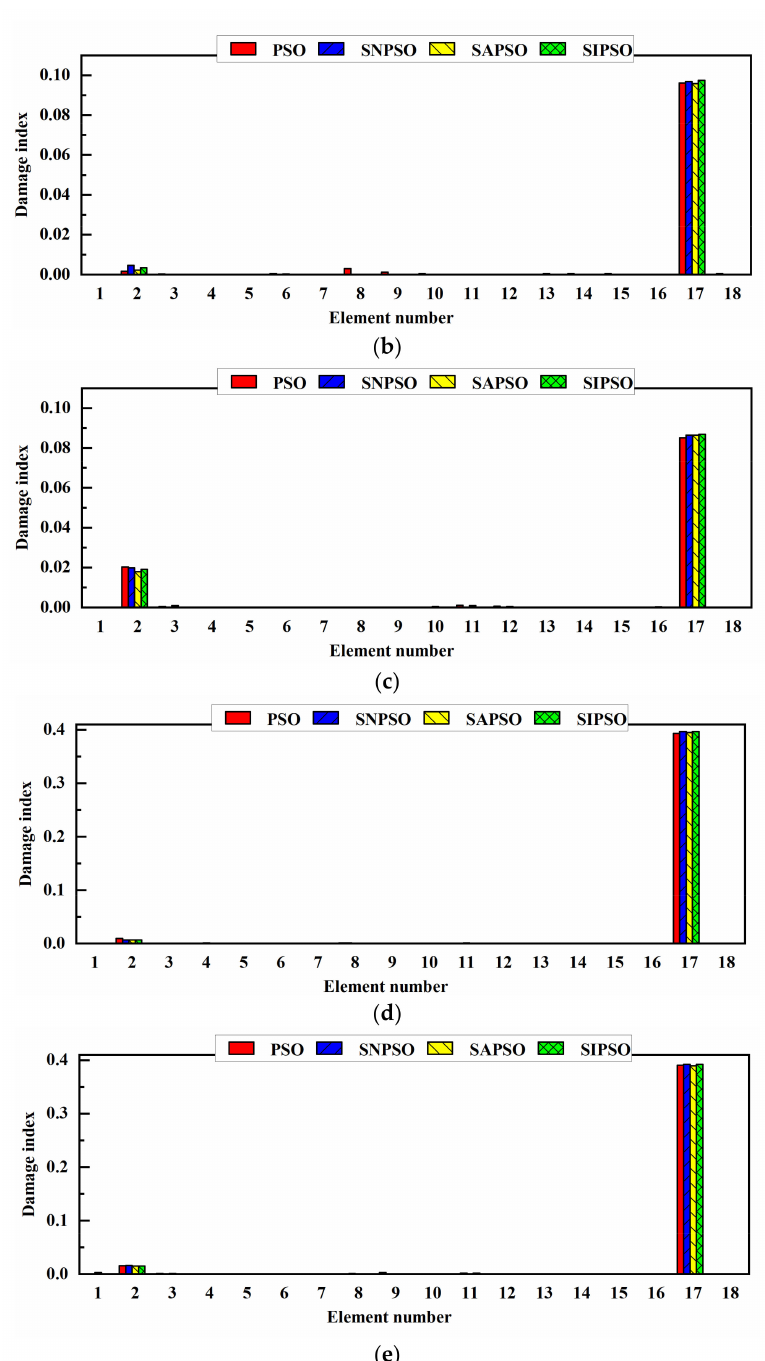
Figure 7. Single damage detection results of four PSO-based algorithms: ( a ) 10% damage index without noise; ( b ) 10% damage index with 5% noise level; ( c ) 10% damage index with 10% noise level; ( d ) 40% damage index with 5% noise level; ( e ) 40% damage index with 10% noise